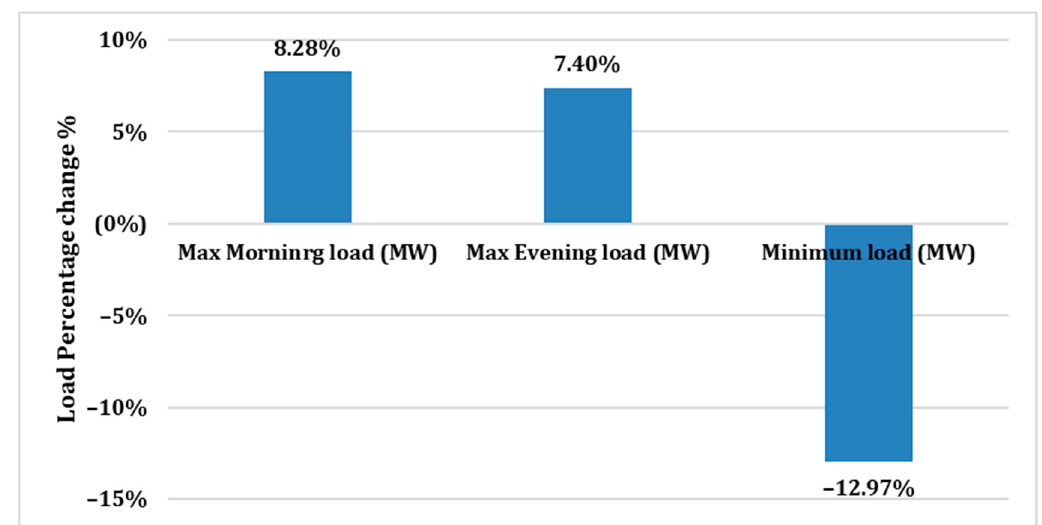
Figure 4. Percentage change in peak load between 2019 and 2020.